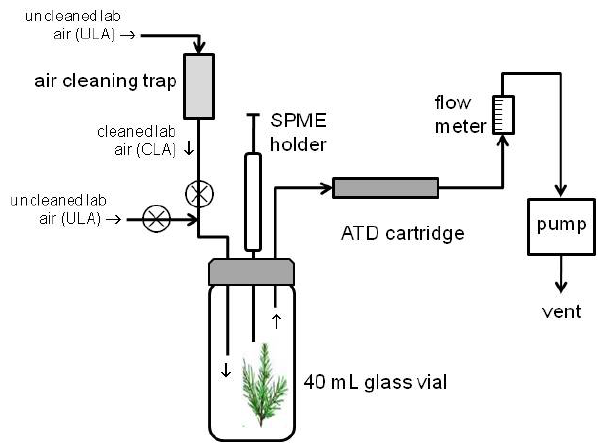
Fig. 1. Diagram of system used to obtain SPME and ATD samples of VBOCs in the laboratory with samples of Cedrus atlantica